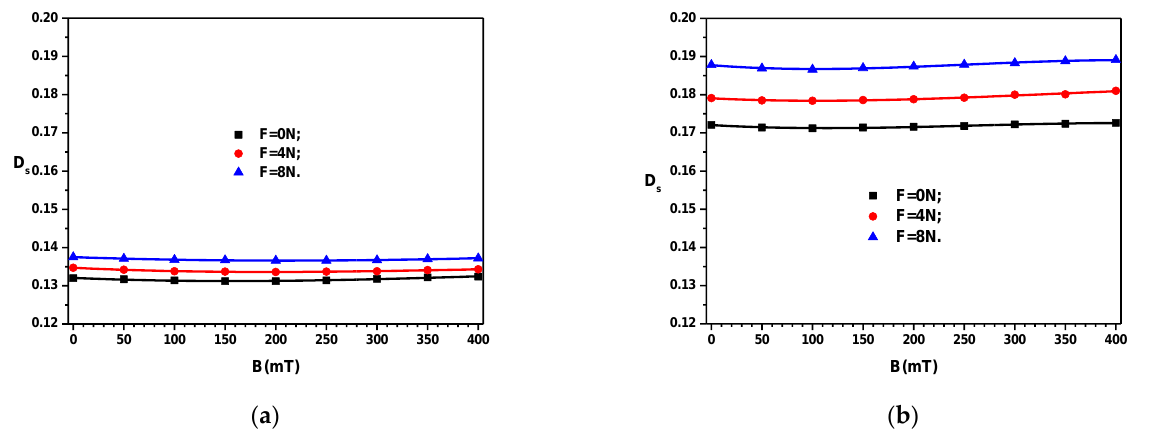
Figure 7. Loss tangent D S of the devices ED as a function of values B of the magnetic flux density superimposed on the electric field with the frequency f = 1 kHz, and values F of the force as a parameter. ( a ) MC 1 . ( b ) MC 2 .